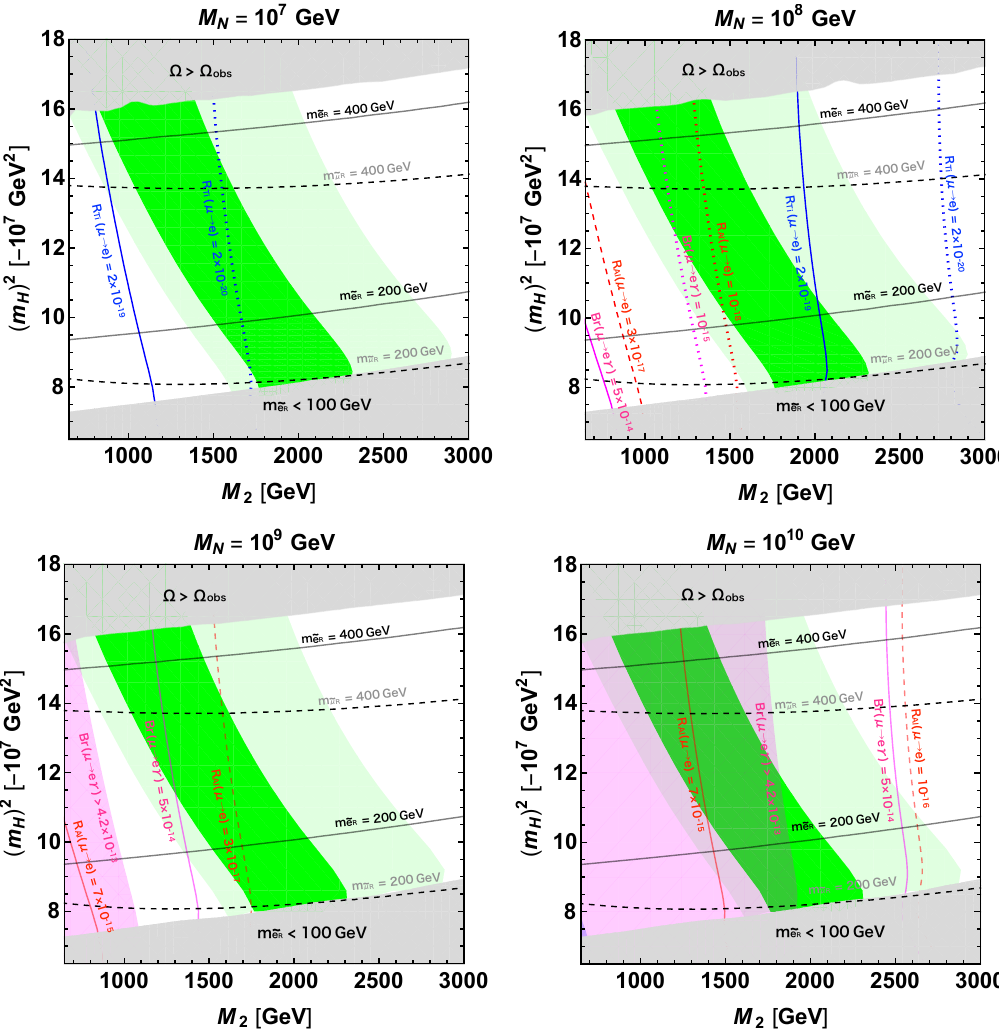
Figure 10 . Contours of the muon g − 2 and LFVs in the model C with the degenerated RH neutrinos. The parameters are same as figure